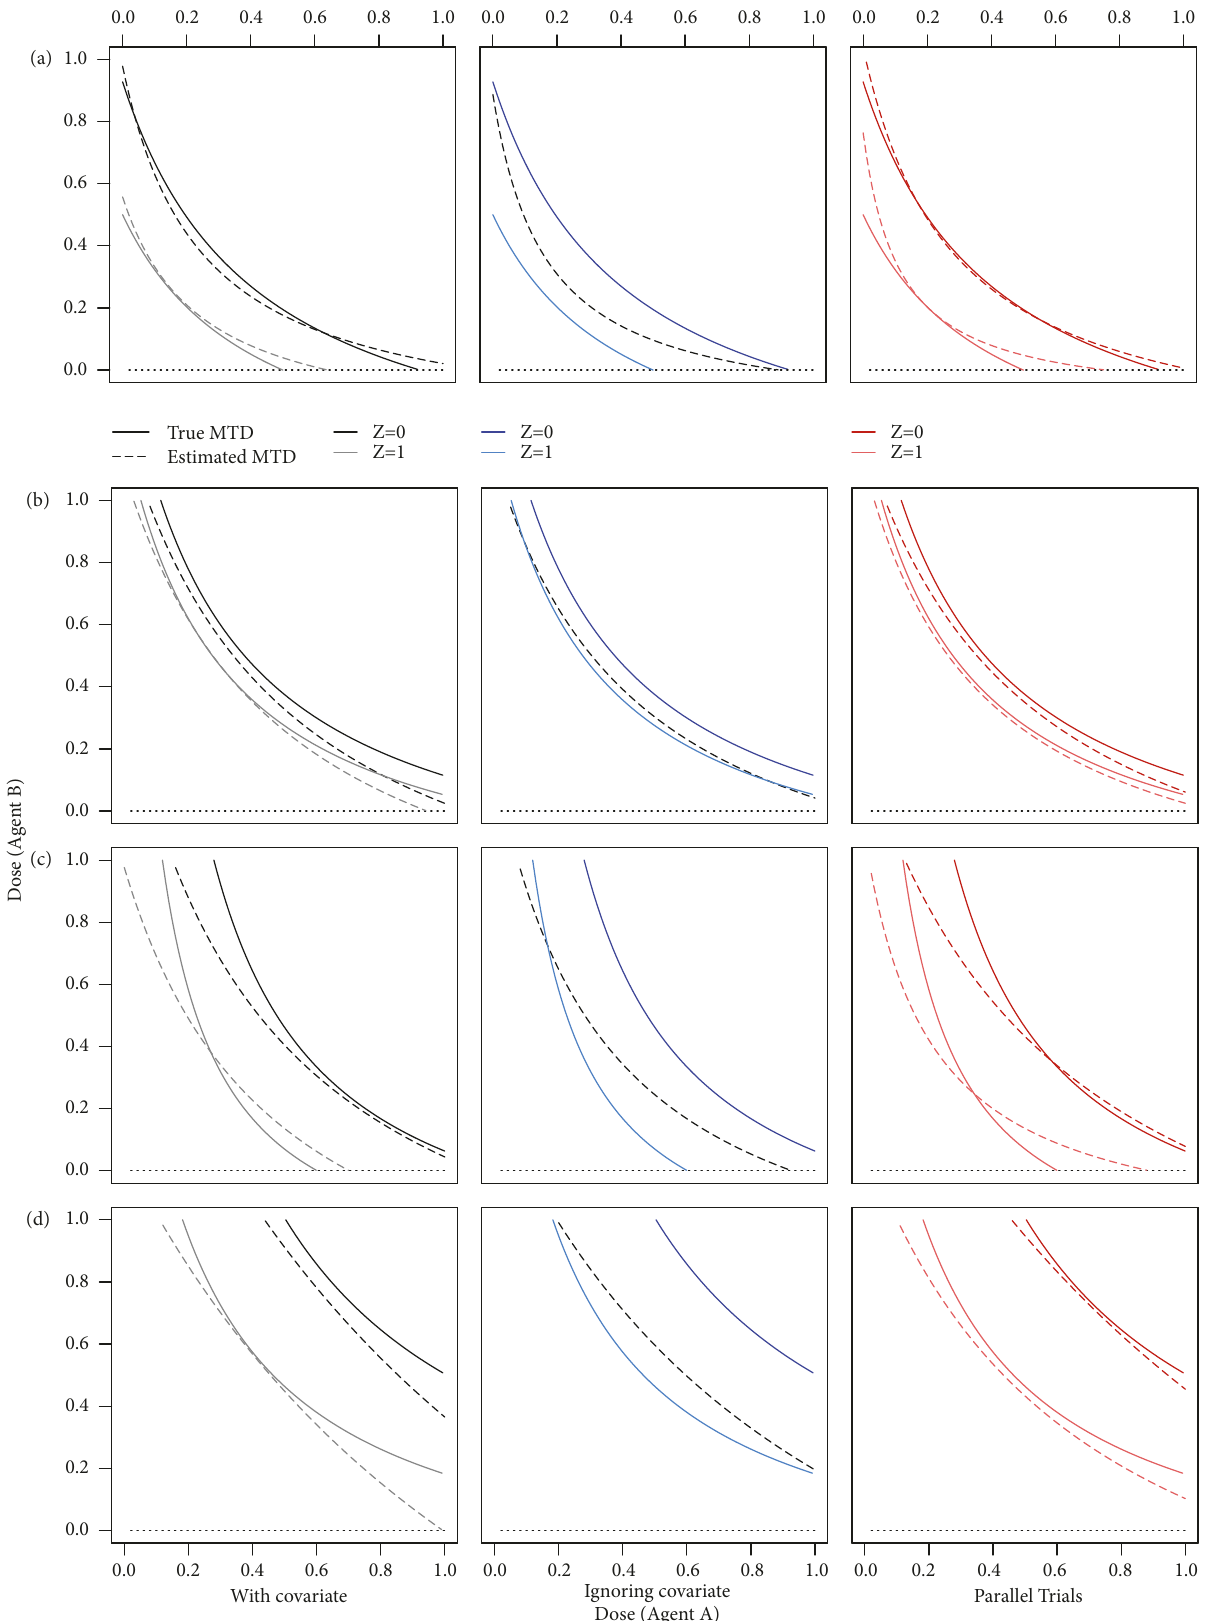
Figure 1: True and estimated MTD curves from 𝑚 = 1000 simulated trials with designs using a covariate (WC), ignoring the covariate (IC), and parallel trials (PT) under four scenarios